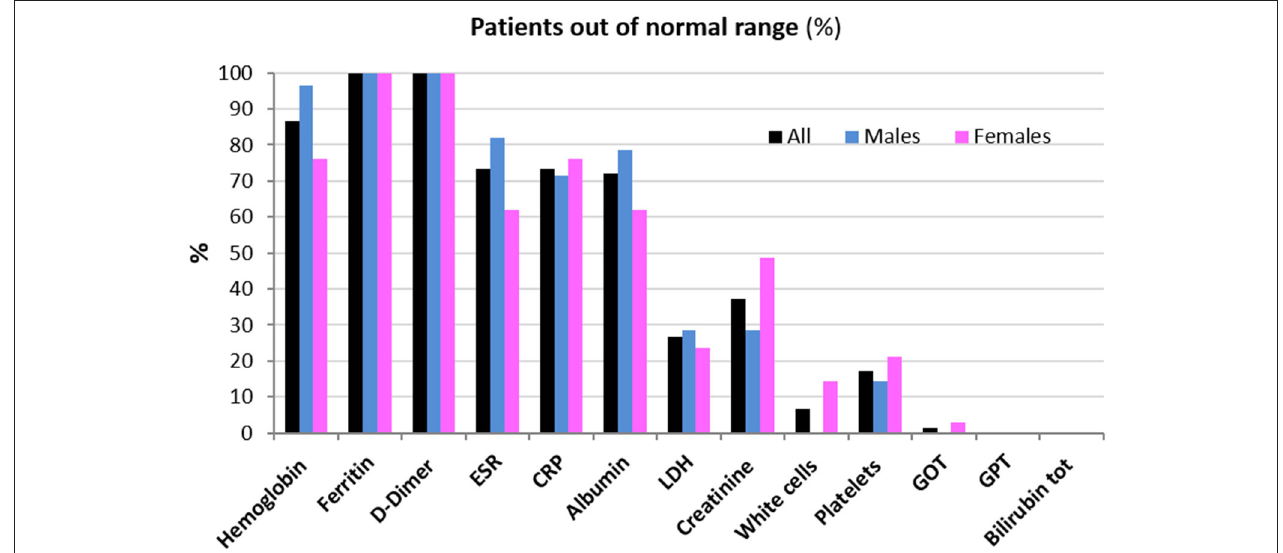
FIGURE 1 | Patients (%) whose hematological data are out of the normal range 60 days from hospital